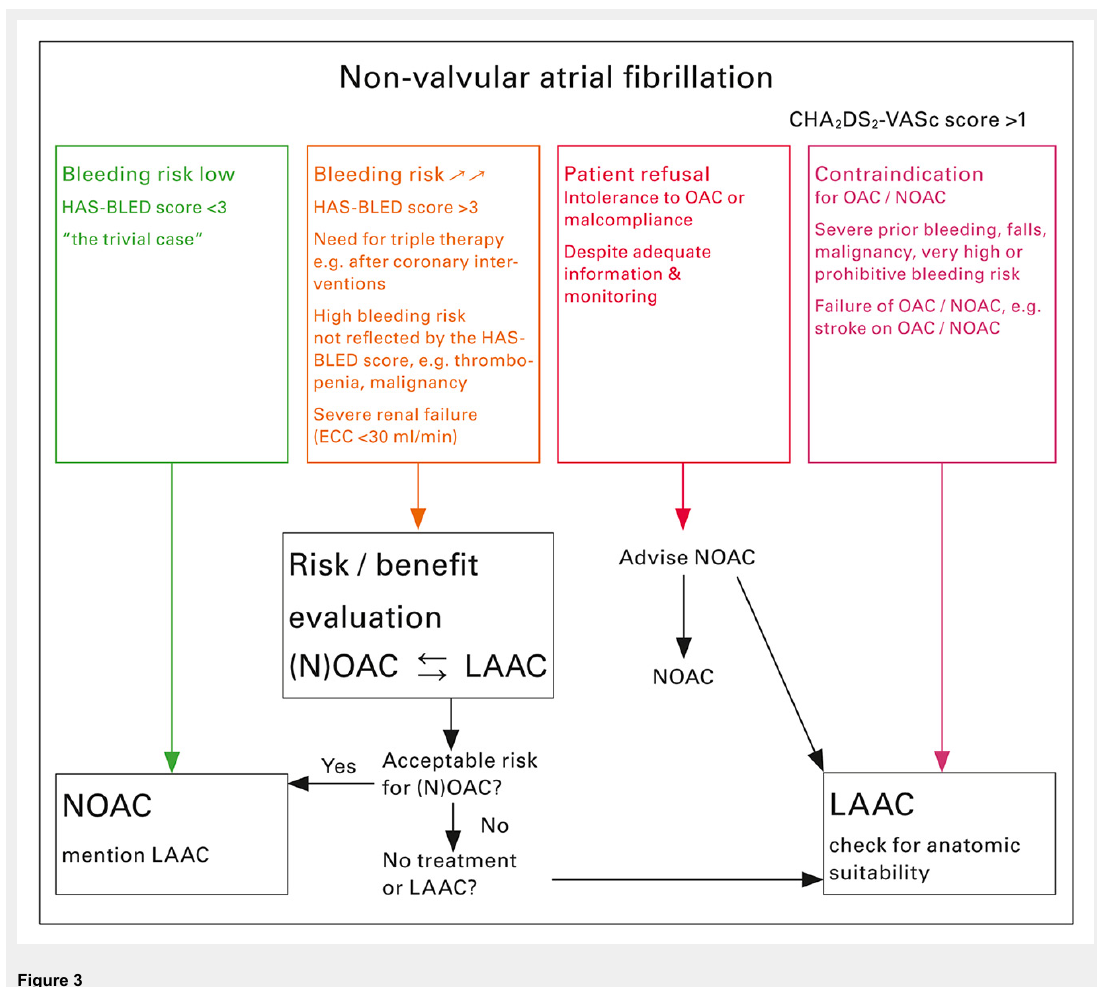
Recommended algorithm for stroke prevention in patients with atrial fibrillation (reproduced modified from the 2014 expert consensus statement of the European Heart Rhythm Society and the European Association of Percutaneous Cardiovascular Interventions [50]). The additional strategy of LAAC centres on a risk/benefit evaluation of the optimal treatment for each patient. Hereby, it is supposed to contribute both to improved safety and efficacy outcomes as well as to offer protection from stroke and death to patients who have been left without any treatment so far. LAAC = left atrial appendage closure; NOAC = non-vitamin K-dependent oral anticoagulant; OAC = oral